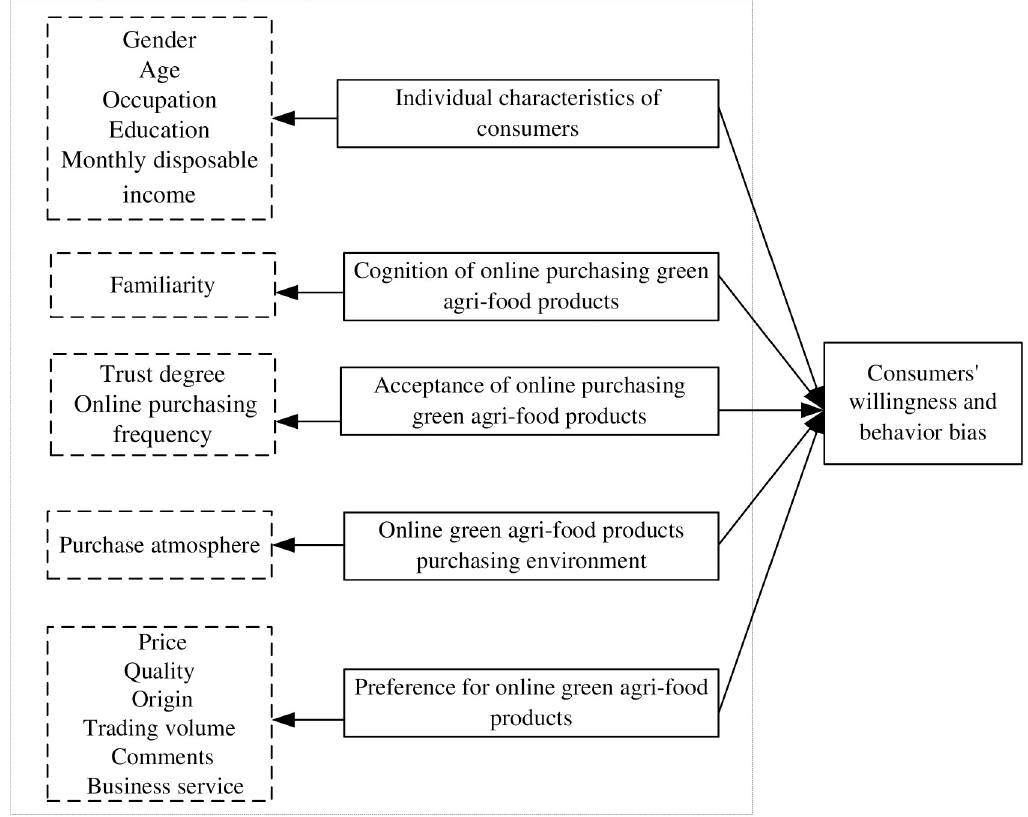
Fig 1. The basic framework of consumers’ willingness and behavior to purchase green agri-food